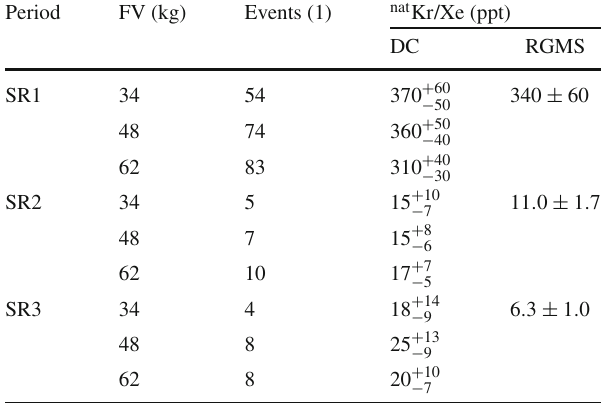
Table 3 Result of the delayed coincidence study for the three SRs and considering three different fiducial volumes (FV). The number of tagged events is converted into a krypton concentration (DC). The con- centrations can be compared to the corresponding SR-averaged off-line measurements (RGMS). See text for